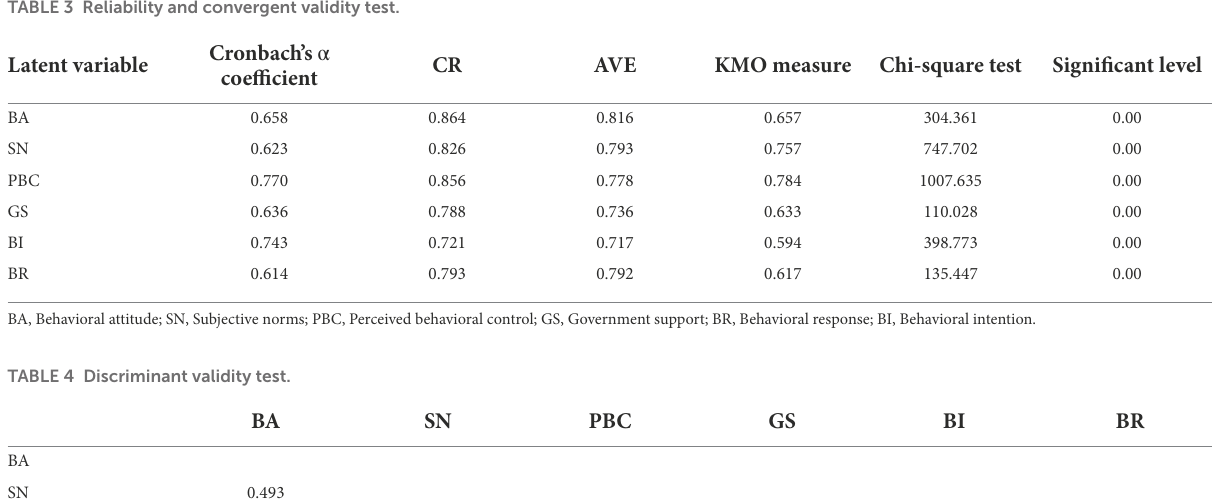
TABLE 3 Reliability and convergent validity test.